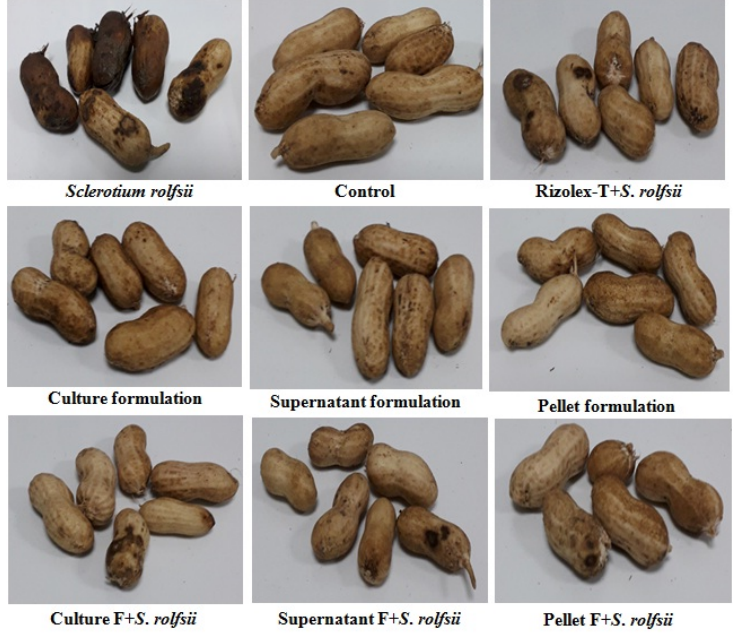
Figure 8. Effect of talc-based culture, supernatant, and pellet formulations of Streptomyces cellulosae Actino 48 on peanut pod rot disease compared with Rizolex-T fungicide under artificial infection and greenhouse conditions. Table 4 shows the effect of treatment by talc-based culture, cell-free supernatant, and pellet formulations of Actino 48 on peanut yield under greenhouse conditions. Treatments high dry weight of healthy pods ( 11 .62 and 10.63 g pot −1 , respectively) with yield increases